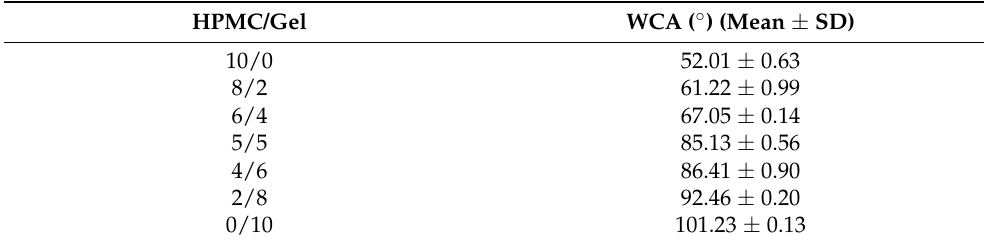
Table 2. Water contact angle of HPMC-based composite